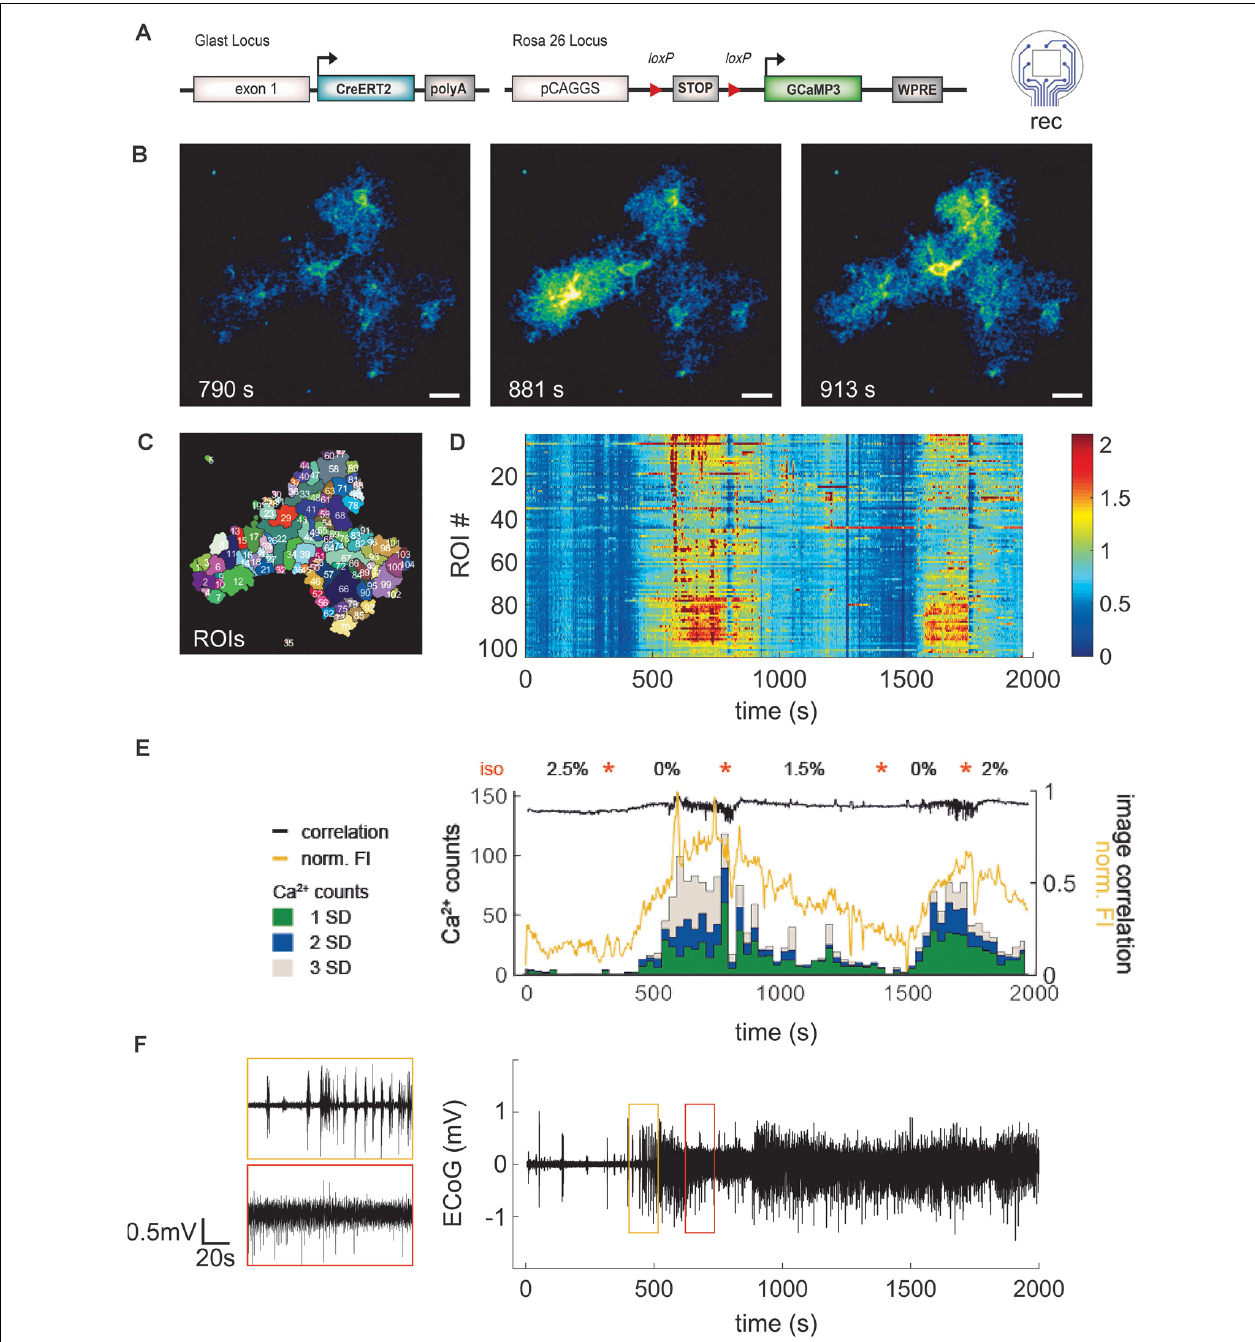
FIGURE 6 | Application of LCP electrode for ECoG recording combined with 2P- Ca 2+ imaging substantiates reduction of spontaneous astroglial Ca 2+ signals under anesthesia. (A) Eight-channel ECoG recording and simultaneous 2P-Ca 2+ imaging in transgenic mice with GCaMP3 expression in astrocytes. (B) 2P-LSM sequence displaying good cranial window quality with implanted LCP electrode 35 days post-surgery, scale bar = 20 µ m. (C) Regions of interest (ROI) map computed by activity-dependent analysis using custom-made Matlab routines. (D) Heatmap illustrating normalized Ca 2+ signal amplitudes [( F − F 0)/ F 0] per ROI over time. Graphs (D–F) have the same time scale and isoflurane variations (orange stars). In contrast to the anesthetized state, awake mice display higher Ca 2+ signal amplitudes. (E) Ca 2+ events (counts) were grouped into small (1 SD), medium (2 SD), and large (3 SD) signals and merged with corresponding normalized fluorescence intensity of the image (FI, yellow trace) and image correlation (black trace). Anesthesia reduced particularly the frequency of medium and large Ca 2+ signals which were highly abundant in awake animals. Increases of Ca 2+ events were accompanied by rises in fluorescence amplitude and variation of image correlation. Orange stars indicate transitions between isoflurane concentrations. (F) ECoG trace displayed as average over all channels shows clear transitions in brain activity depending on the anesthesia level.